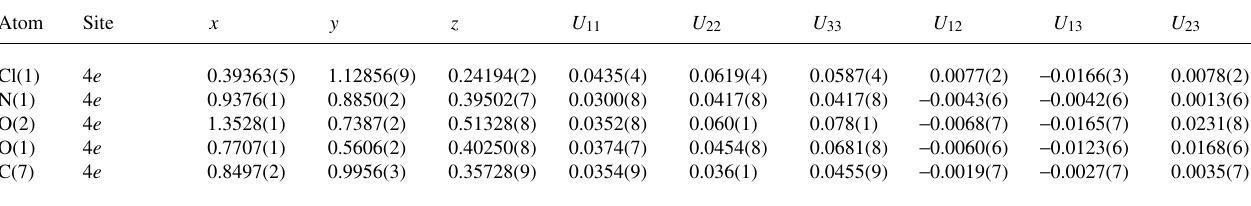
Table 3. Atomic coordinates and displacement parameters (in Å 2 )